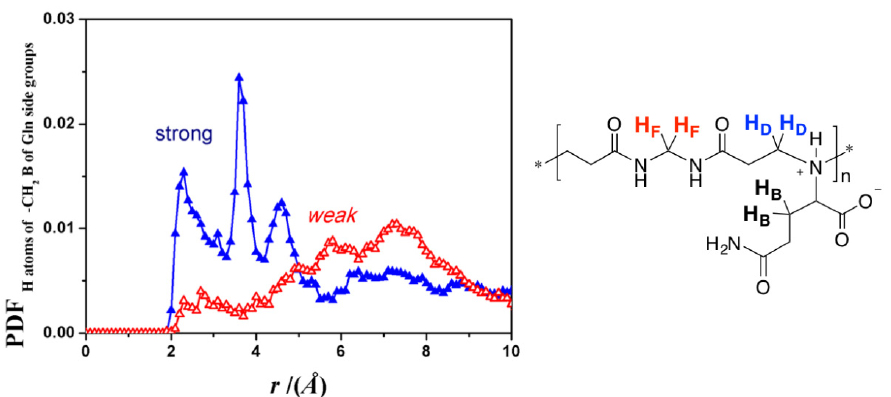
Figure 9. Pair distribution function (PDF) for M- l -Gln at pH 4.5. Distribution of distances between the side chain H B atoms (black in the structure of the repeat unit) and the H D (blue) and H F (red) main chain atoms.